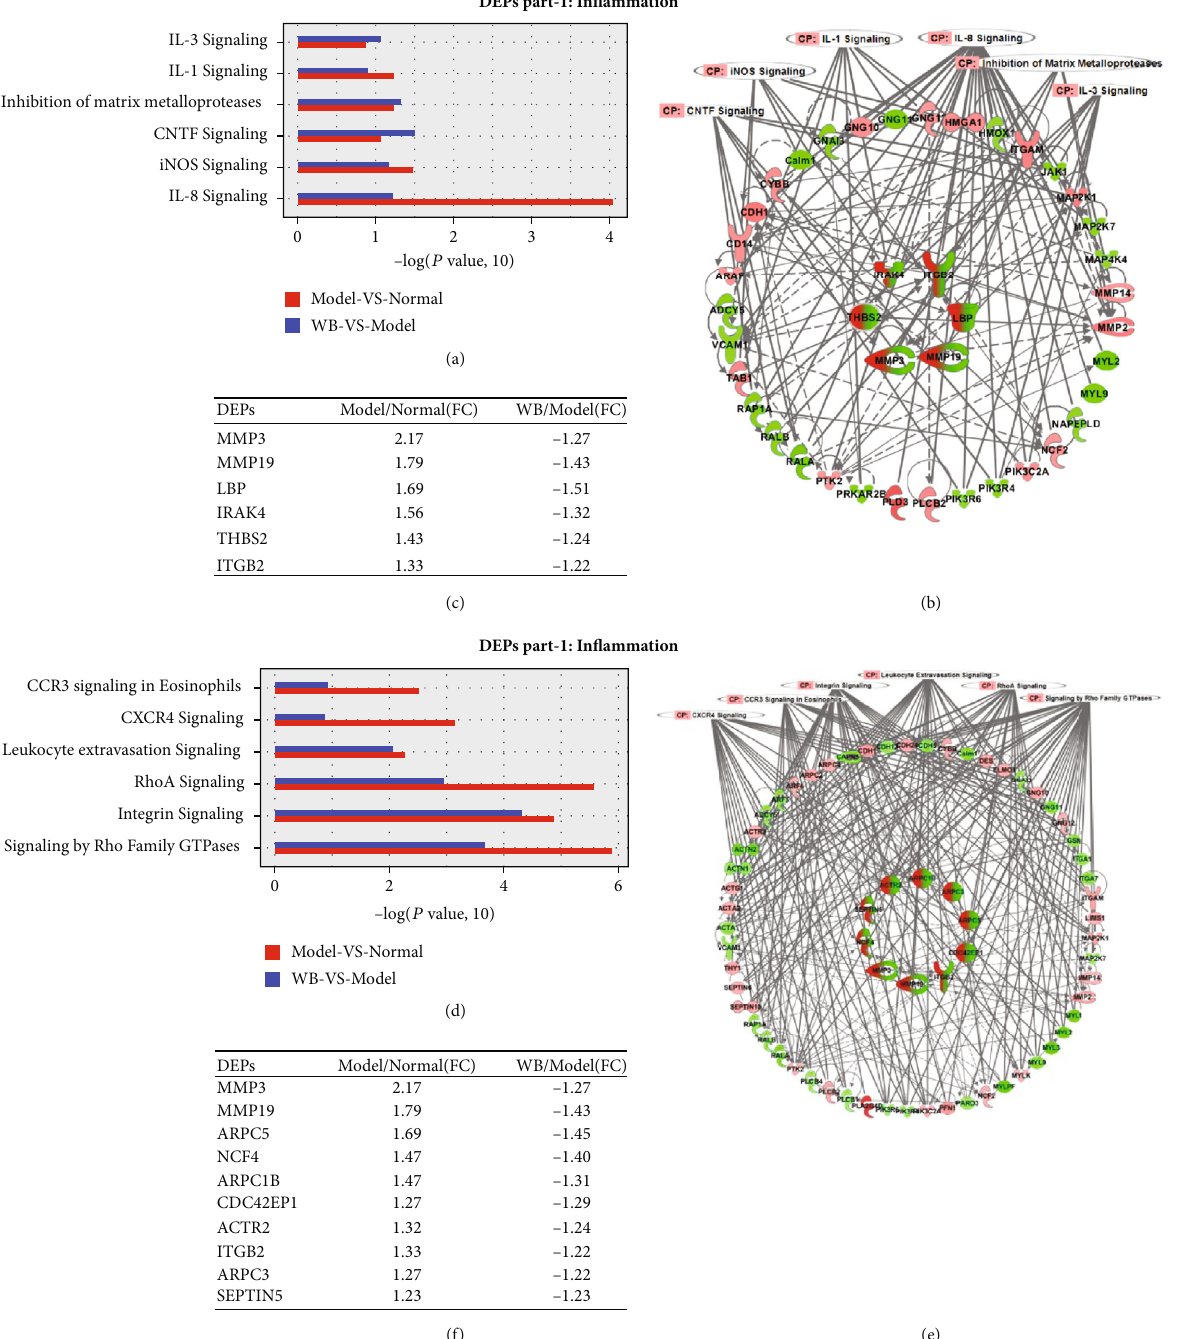
Figure 5: The pathway and network analysis of DEPs in WB vs. model and model vs. normal. (a, d) The ingenuity canonical pathway enrichment analysis of DEPs part 1 and DEPs part 2 was analyzed, and the threshold was set as − log ð P value, 10 Þ > 0 : 85 . (b, e) The protein-protein interaction network of DEPs part 1 and part 2 were generated, respectively. (c, f) The fold changes of shared DEPs in in fl ammation network and cell migration network were listed, respectively. Note: in (b) and (e), the outer rings were unshared DEPs in model vs. normal or WB vs. model, pink color represented upregulation of protein expression, and green color represented downregulation of protein expression. The inner rings were shared DEPs, red color represented upregulation of protein expression in model vs. normal, and green color represented downregulation of protein expression in WB vs.